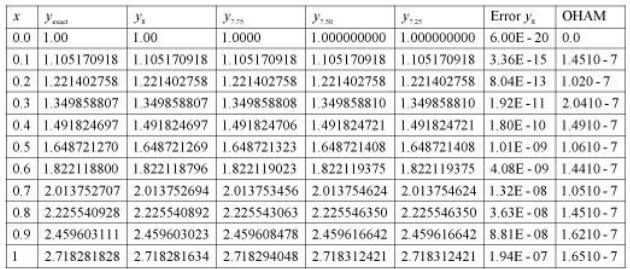
Table 3: The numerical results for Problem 3 for different fractional order .